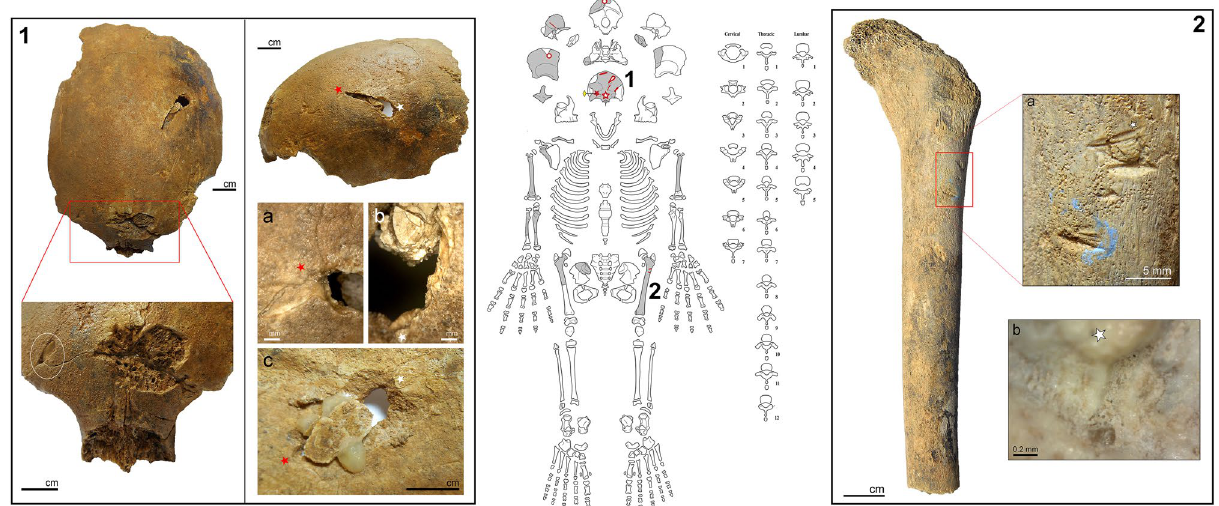
Figure 2. Location and images of the observed osseous lesions on JS 14. Center: schematic scheme of JS 14 ′ s skeletal preservation. Grey parts represent preserved bones, star = blunt force trauma, full star = unhealed puncture, open circle = perforations, yellow diamond = embedded artefact in a puncture, dash = drags traces of projectile impacts, line = cutmark. Box n°1: lesions of the frontal bone on JS 14. Left: superior view of the frontal bone with, below, the magnification in frontal view of the red box showing the blunt force trauma and the embedded lithic (white oval) with hinge fractures. Right: left lateral view of the frontal bone displaying the projectile perforation. Red and white stars are reference points for the magnified area; a = hinge fractures at the level of the entrance of the projectile; b = crushing fractures on the border of the perforation; c = endocranial view of the internal beveling. Note the miss-glued piece of bone associated to the perforation, part of the original conservation works. Box n°2: Projectile impact marks on the left femur of JS 14. Left: anterior view of the preserved part of the left femur. a = close up on the two set of drag marks located on the antero-lateral side of the shaft. White star put as reference point for the magnified area. b = detailed view of the superior drag revealing the wide flat bottom of the groove and the parallel microstriations (magnification